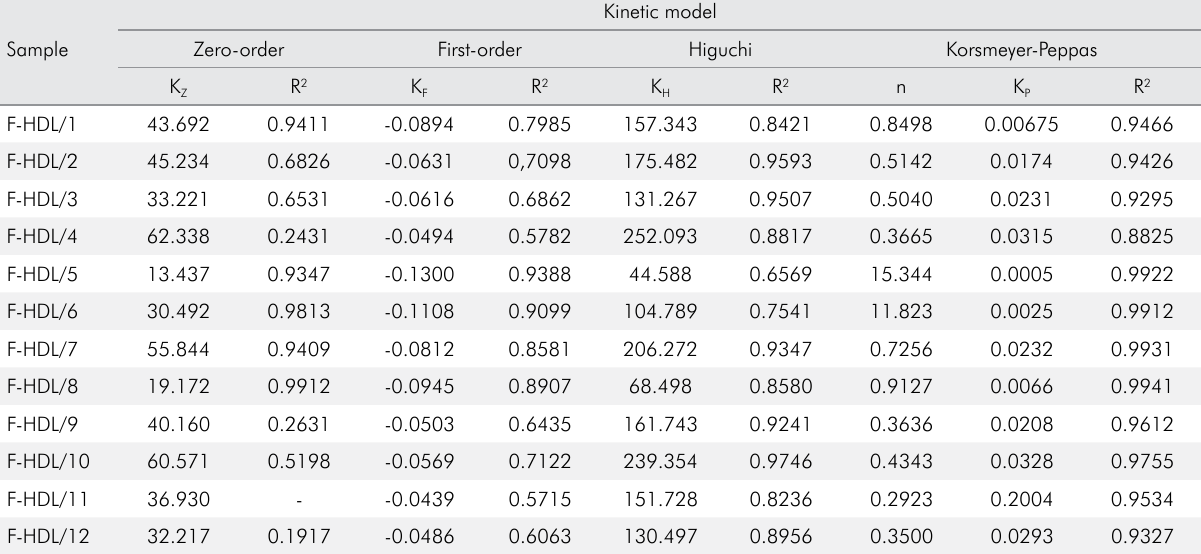
Table 4. Estimated kinetic parameters of drug release (Acid medium).